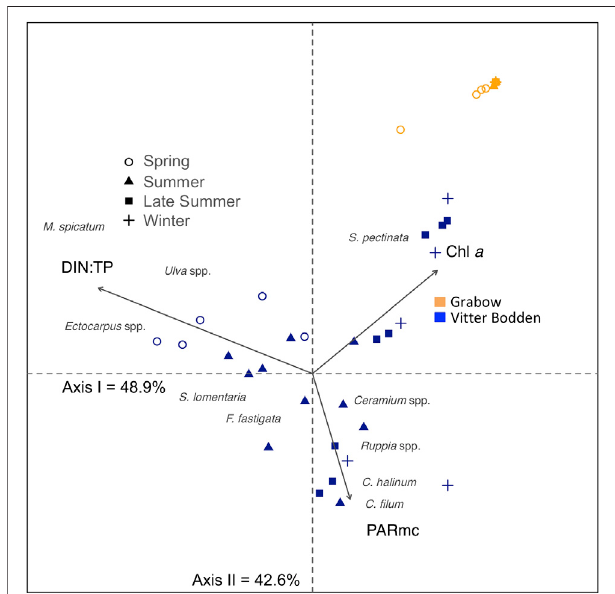
FIGURE 4 | Canonical correspondence analysis plot for the macrophytobenthic biomass sampled in spring (March/April, circle), summer (June/July, triangle), late summer (August/September, square), and winter (November/December, cross) in Vitter Bodden (blue) and Grabow (orange). Shown macrophytobenthic species are Ceramium spp, Chaetomorpha linum , Chorda fi lum , Ectocarpus spp, Furcellaria fastigata , Myriophyllum spicatum , Ruppia spp, Stuckenia pectinata , Sytosiphon lomentaria , Ulva spp.. Environmental factors (arrows) are calculated underwater irradiances within the macrophyte canopy (PARmc), dissolved inorganic nitrogen to total phosphorus ratio (DIN:TP), and Chlorophyll a concentration (Chl a ). Positions of macrophytes show their probable occurrence based on the explanatory variables (PARmc, DIN:TP, Chl a ). Only environmental factors signi fi cantly correlated to the ordination ( p < 0.01) are